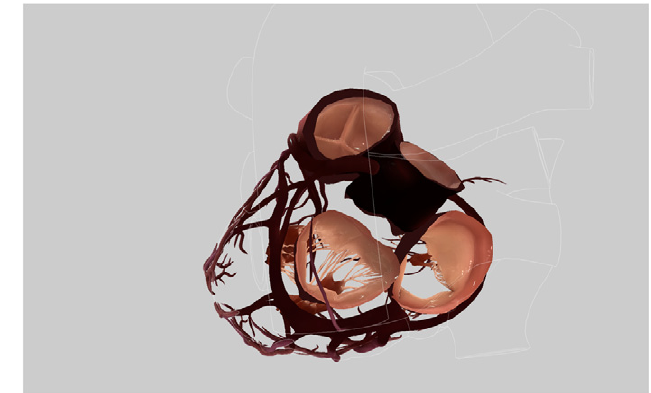
Figure. 5 Simultaneous display of ultrasound image and 3D model.